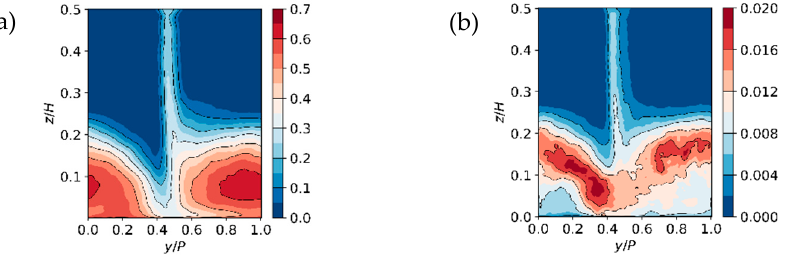
Figure 14. Cutplanes downstream of the blade (plane at x/C = 0.89 ) of ( a ) total pressure losses and ( b ) TKE. Pitchwise coordinate normalized by cascade pitch P with origin such that the wake is located at the centre, PS on the left.